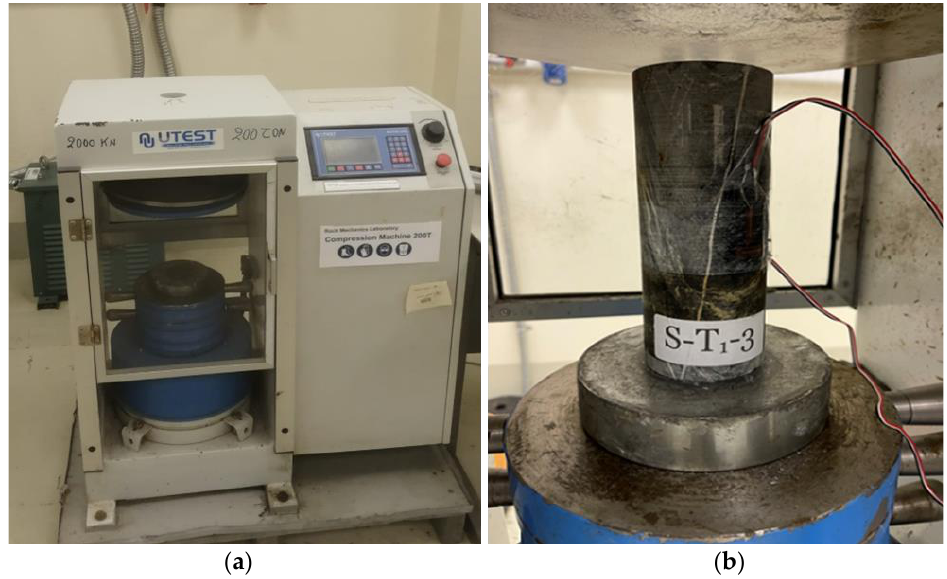
Figure 3. ( a ) Compression machine (Press BC 100, 2000 kN); ( b ) sample S-T 1 -3 during testing in a compression machine.